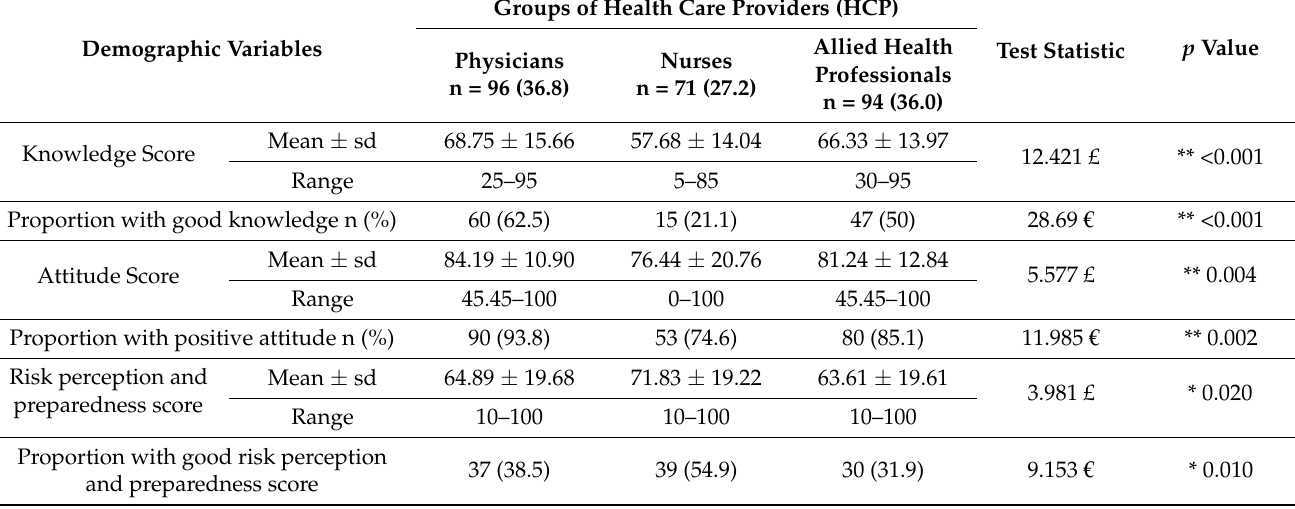
Table 8. Knowledge, attitudes, risk perception, and preparedness scores (in percentages) by groups of health care providers.